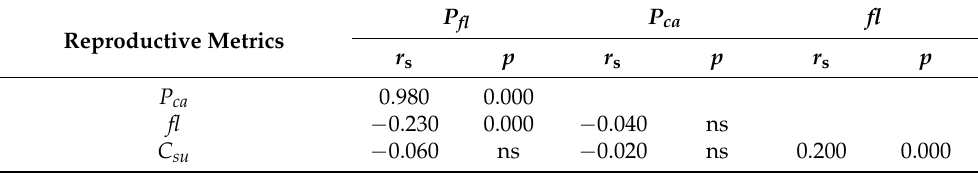
Table 3. Spearman correlations between averaged reproduction metrics for all studied years and 28 birch individuals of the Wildberg seed plantation. r s : Spearman’s correlation coefficient, p :